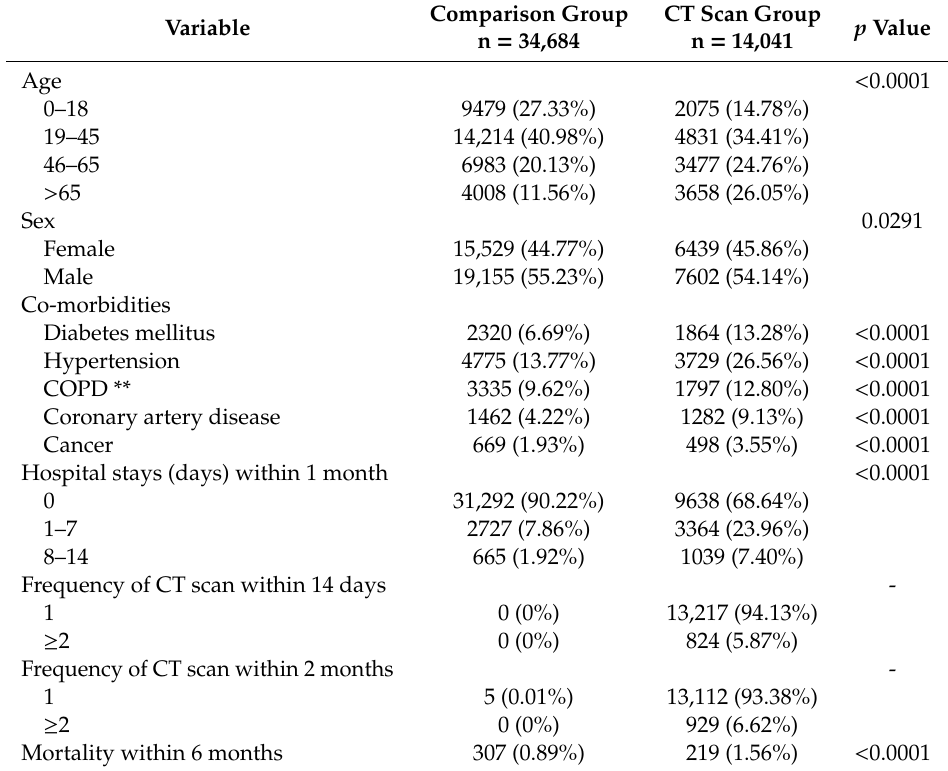
Table 1. Baseline characteristics of CT scan and non-CT *-can patients with minor head